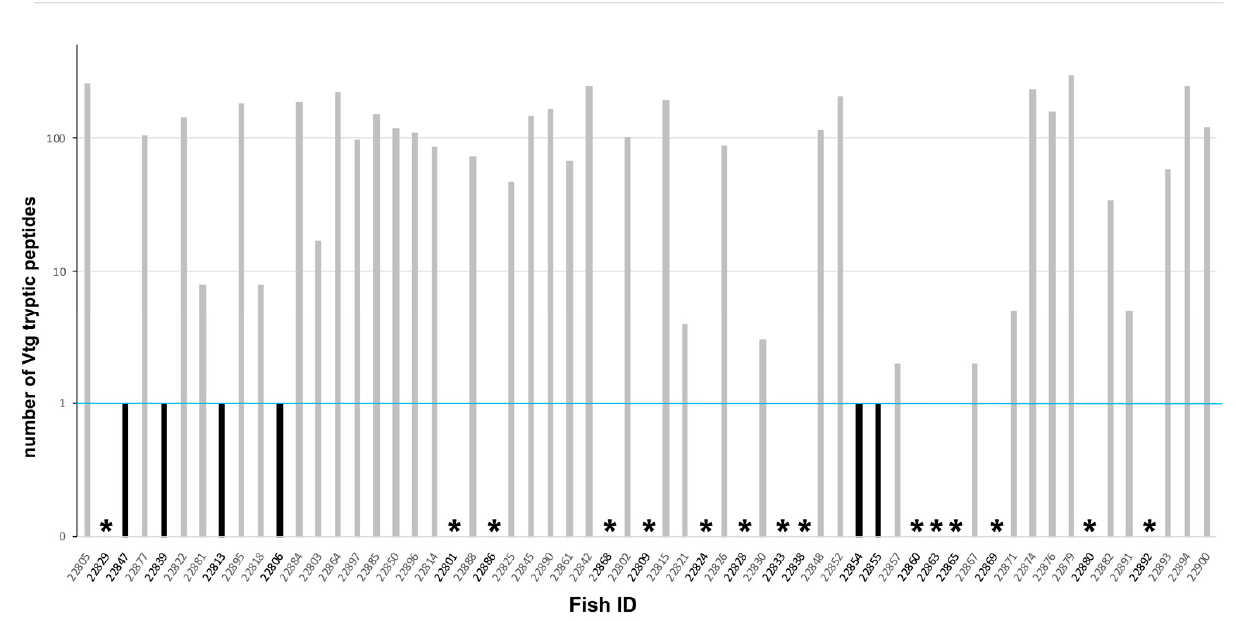
Figure 7. Vtg and Vtg cleavage products Mascot scores determined by mass spectrometry from plasma of sexually mature African bonytongue , Heterotis niloticus , (same individuals as in Figure 6). The fish with a Vtg Mascot score > 90 were considered as females (gray vertical bars), those with a Vtg Mascot score ranging from 0 to 90 were considered as males (black vertical bars and * with bold IDs on the X-axis). The male/female threshold value is represented as a blue line at Mascot score = 90 (log-scale Y-axis).